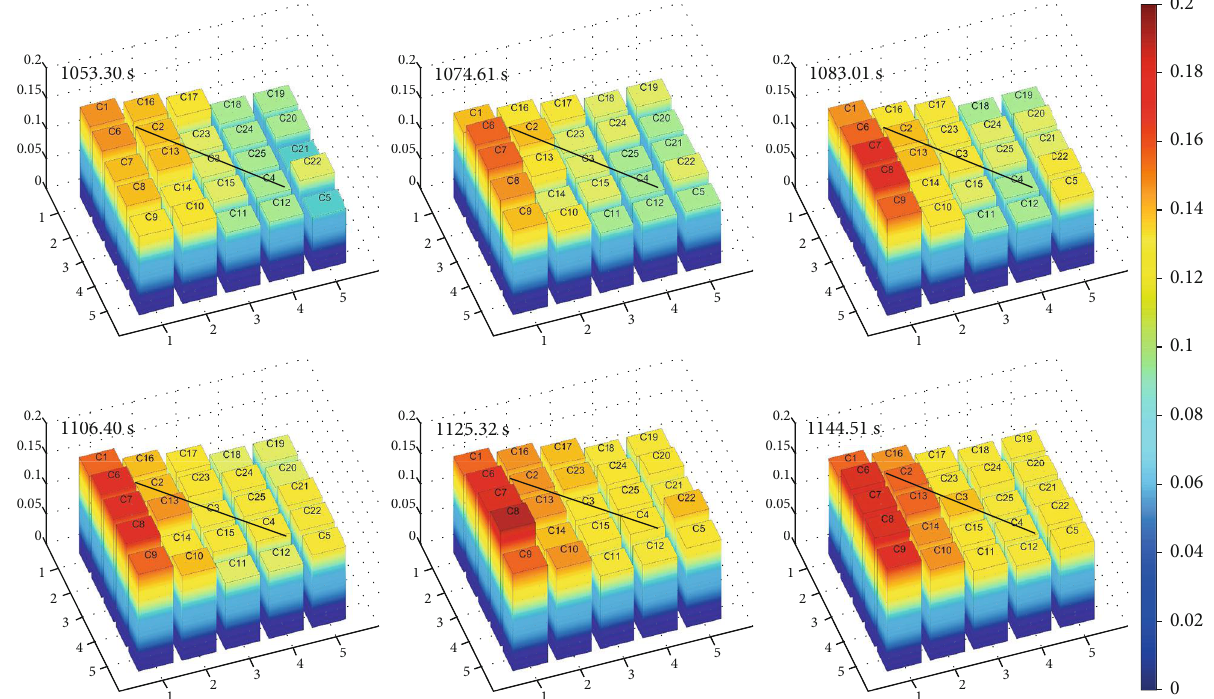
Figure 6: AIRT increment histogram under 22MPa before peak stress (black line indicates the prefabricated crack), reading from left to right and then up to the